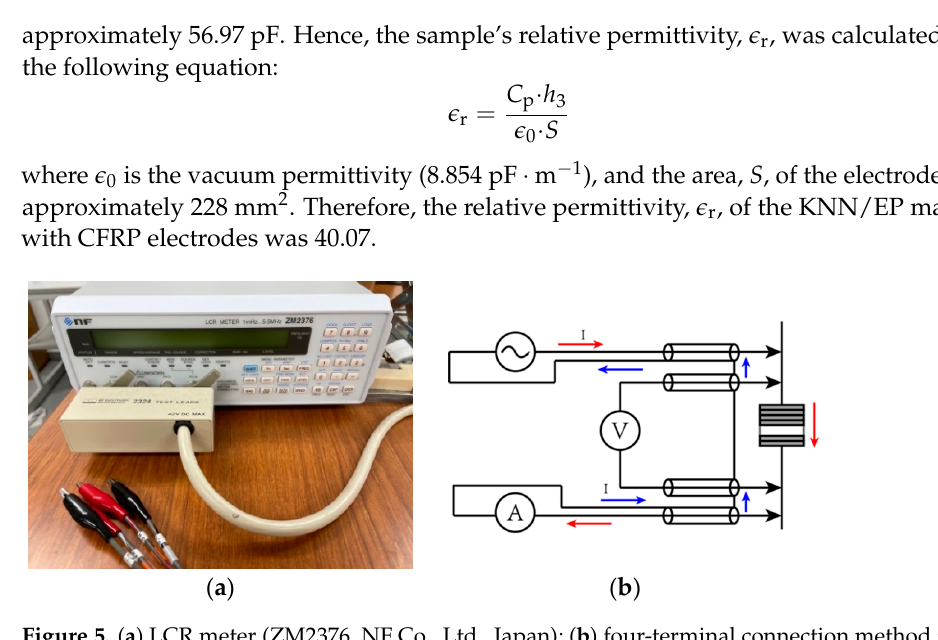
5 of 12 Figure 4. Schematic of the structure of KNN/EP with CFRP electrodes. An LCR meter (ZM2376, NF Co., Ltd., Yokohama, Japan) is a device used to measure the capacitance ( 𝐶 (cid:2926) ) of an electronic component (Figure 5a). The four-terminal Kelvin connections were used in this study to measure the specimen’s permittivity at a voltage